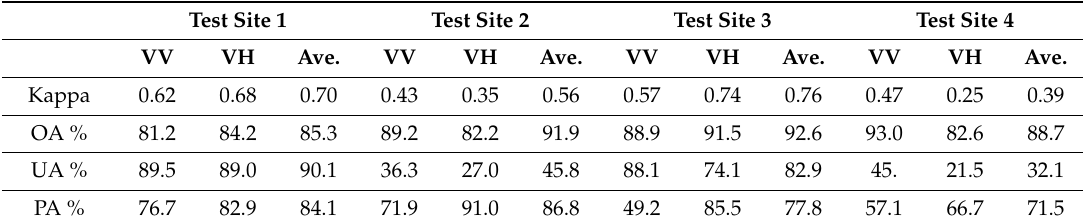
Table 5. Accuracy of four test sites using the proposed method.